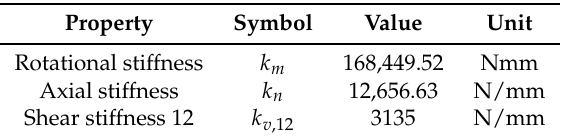
Table 3. Spring model, estimated stiffness parameters per tab of the MTSJ closed slot connection. The stated values are divided by the number of spring connectors of each spring type used within one group.